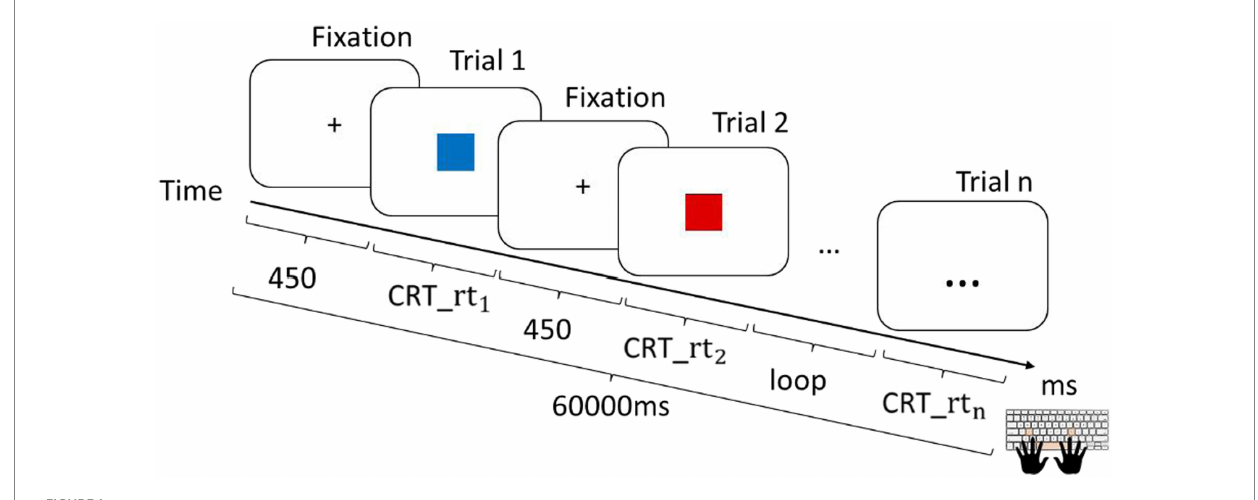
FIGURE 1 Trial sequence of the CRT task. rt, reaction time.